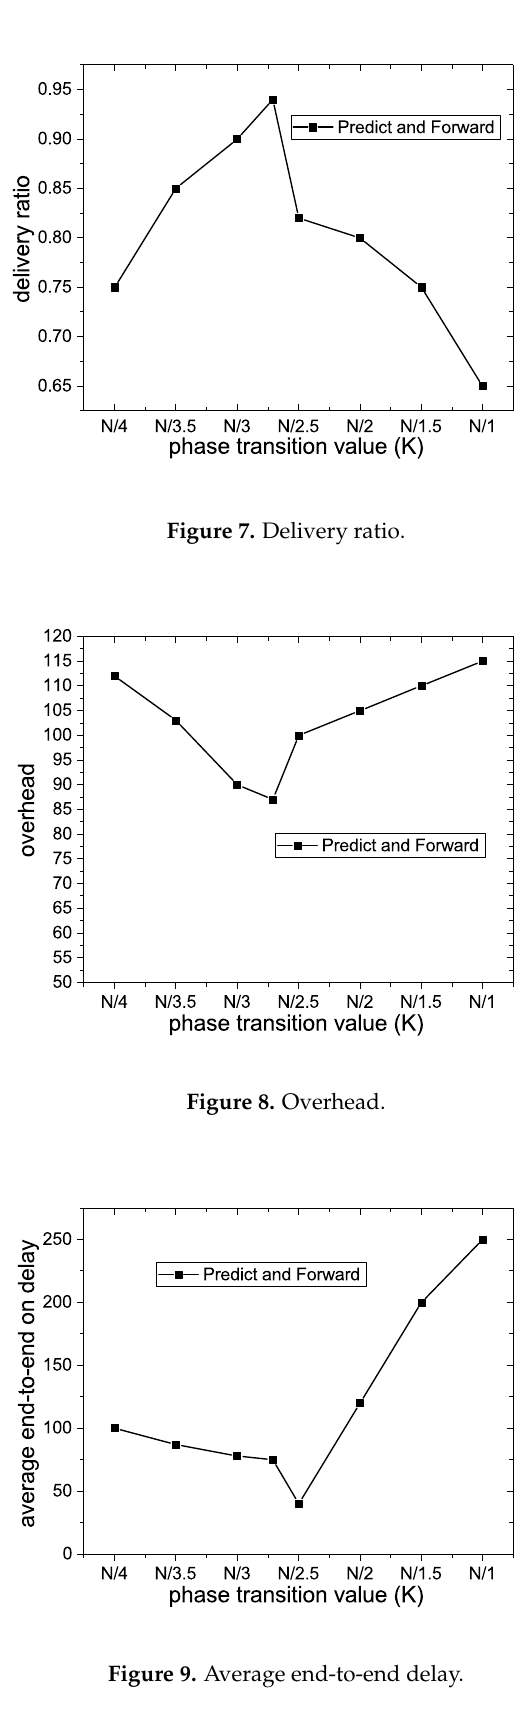
Figure 9. Average end-to-end